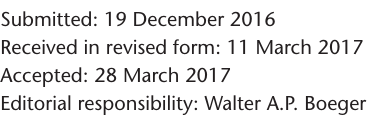
Figure S1. Cephalothorax of Macrobrachium acanthurus exposed to salinities 0 (control), 10, 20, and 30 psu for 4 or 8